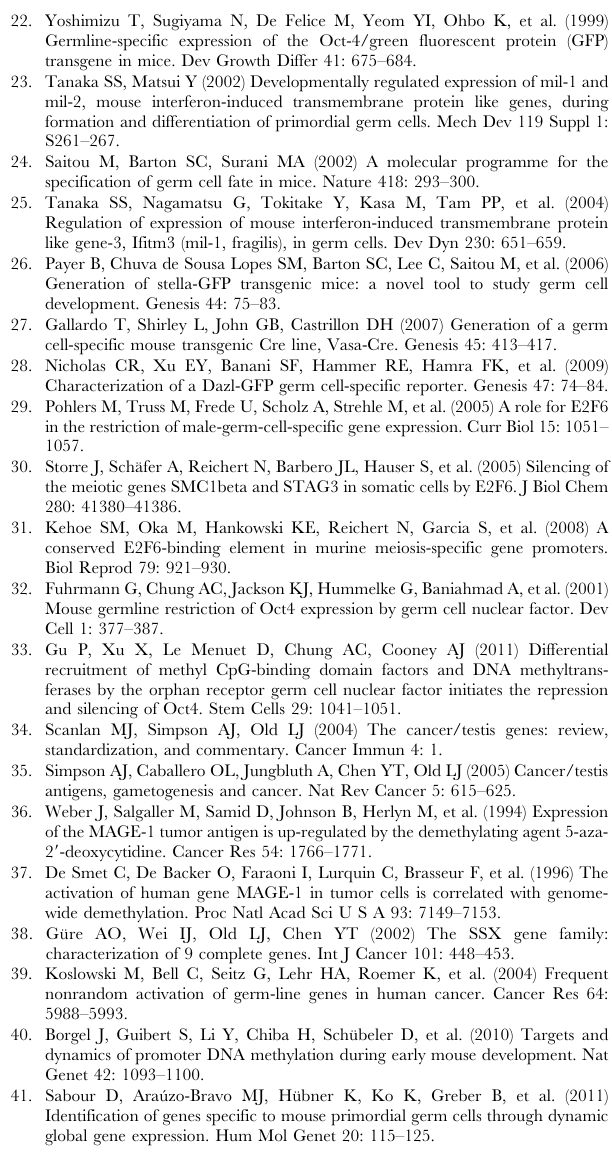
Table S3 Primers used for site-directed mutagenesis of regulatory sequence of mil-1 for the luciferase reporter assay. Capital ‘T’s indicate positions of C to T replacement of CpG sites.